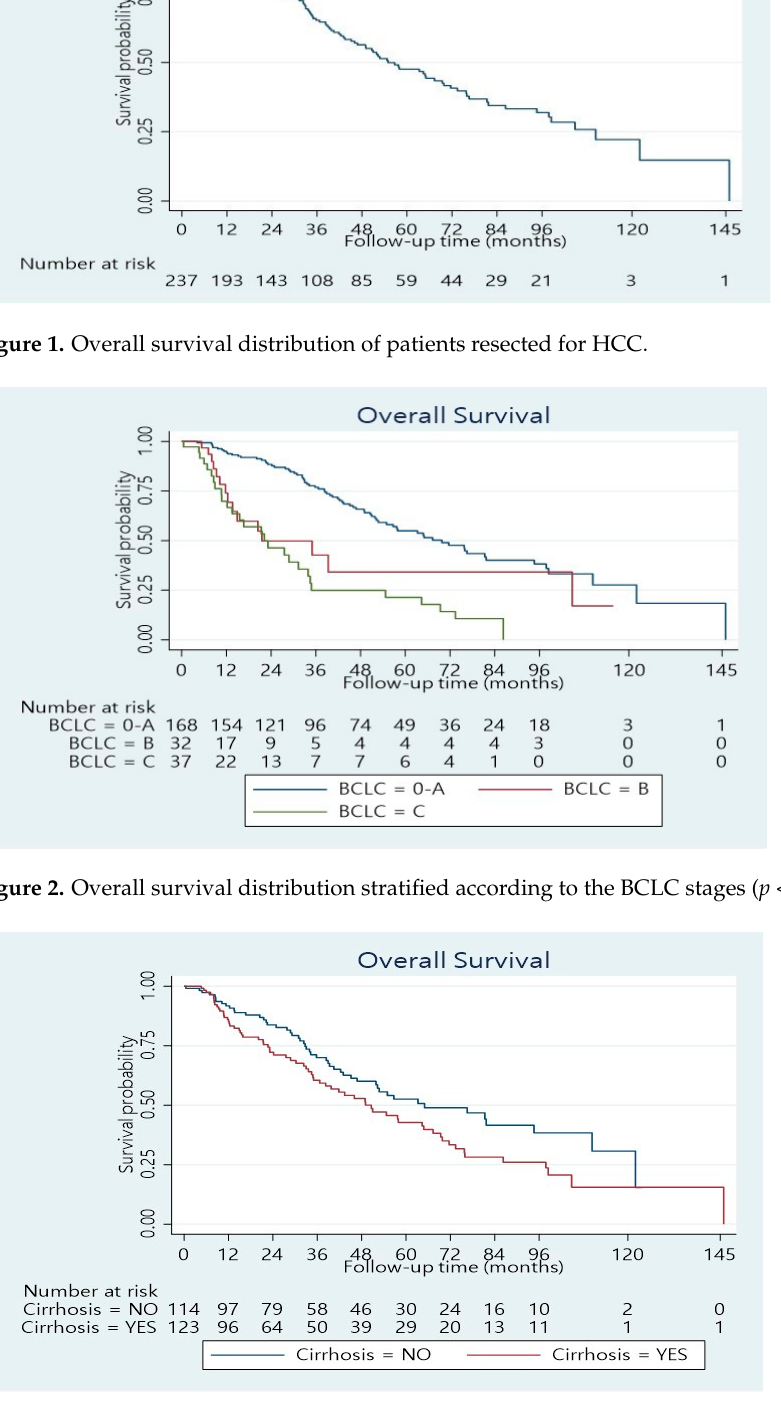
Figure 3. Overall survival distribution stratified according to Cirrhosis status ( p = 0.034). Table 4. Univariate and multivariate analysis of overall survival.